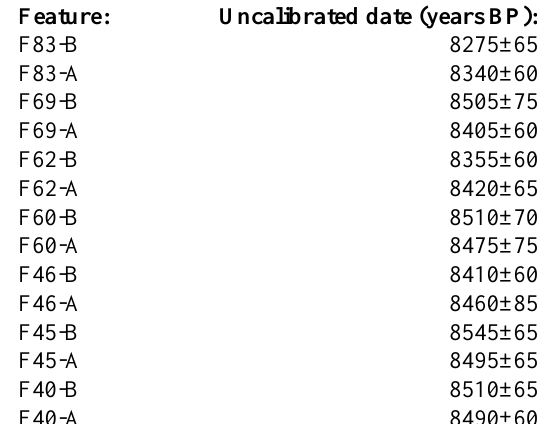
Table 2: Uncalibrated radiocarbon dates Lab. no: